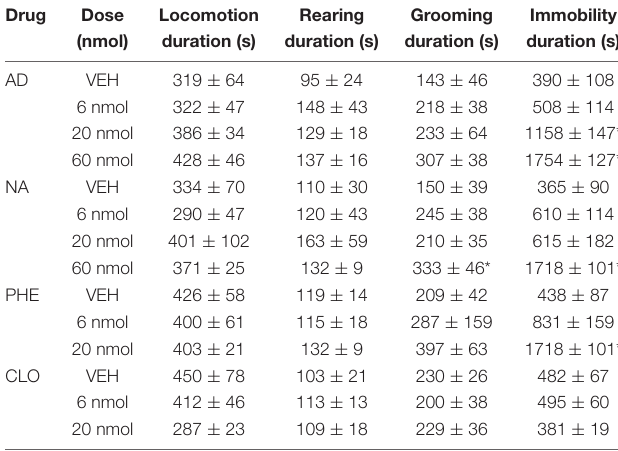
TABLE 3 | Duration of non-ingestive behaviors during 60 min of recording after injection of adrenaline (AD), noradrenaline (NA), phenylephrine (PHE), clonidine (CLO), or vehicle (VEH) into DR of fasted rats.